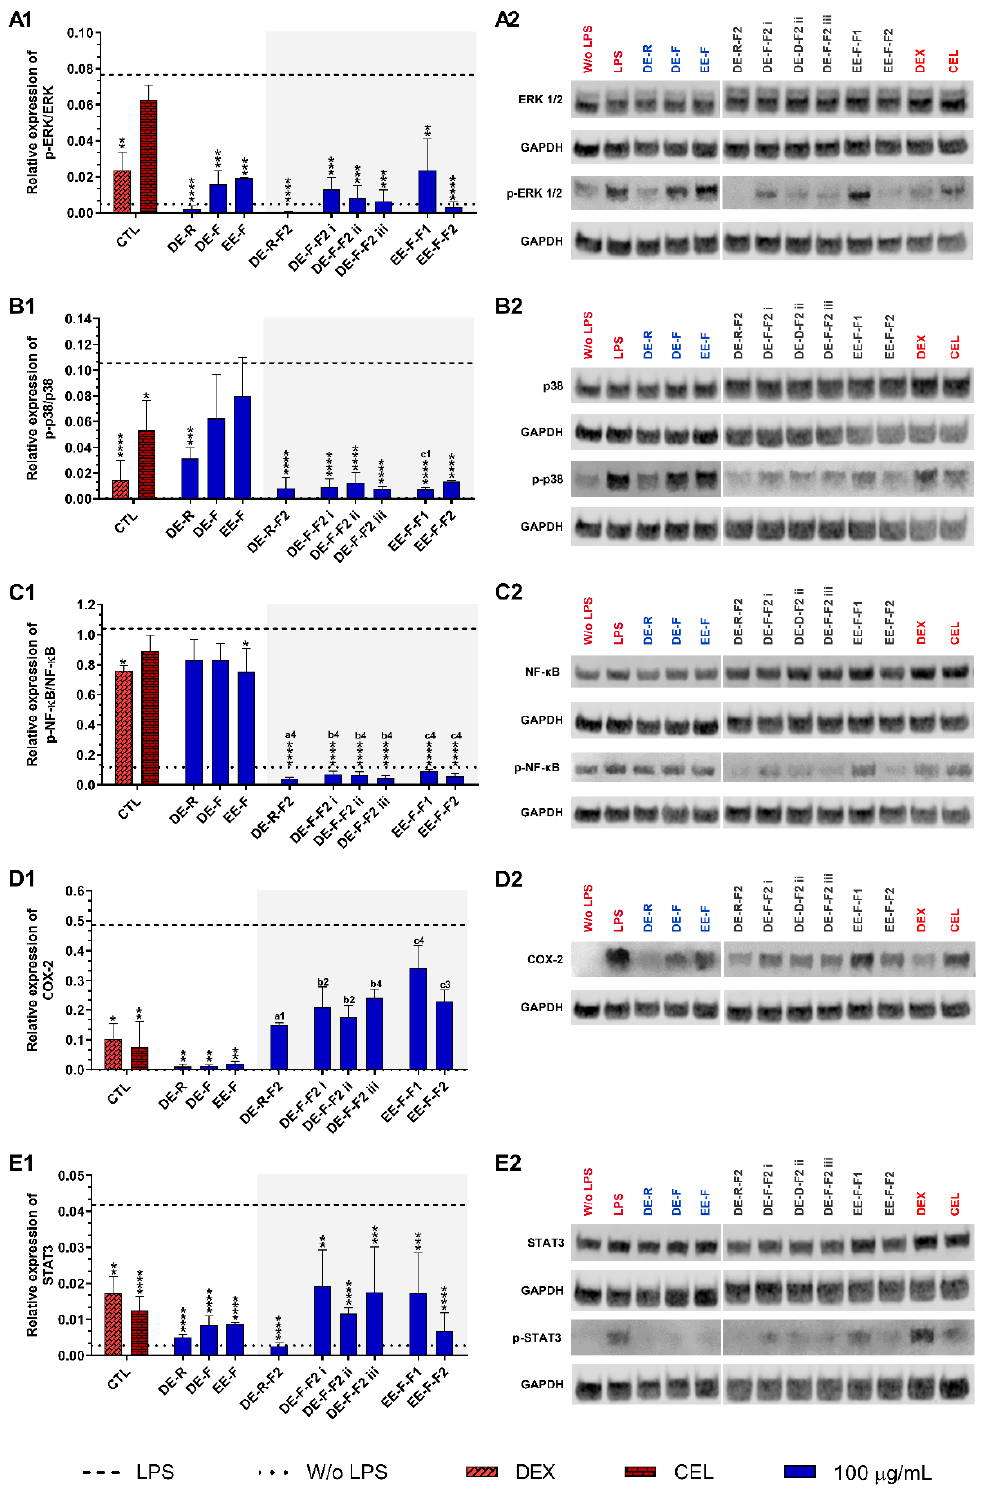
Figure 7. ERK 1/2 ( A1 , A2 ), p38 ( B1 , B2 ), NF ‐κ B p65 ( C1 , C2 ), COX ‐ 2 ( D1 , D2 ), and STAT3 ( E1 , E2 ) signaling pathways downregulation of LPS ‐ stimulated human monocyte ‐ derived macrophages (hMDMs) cultured in the presence of E. purpurea extracts, factions, and clinically used anti ‐ inflammatory drugs (dexamethasone (DEX) and celecoxib (CEL), 10 μ M) for 24 h. Statistically significant differences are * ( p < 0.0381), ** ( p < 0.0071), *** ( p < 0.0009), and **** ( p < 0.0001) in comparison to the positive control (LPS ‐ stimulated hMDM without treatment) for each tested E. purpurea extract and fraction, as well as DEX and CEL and 1 ( p < 0.0358), 2 ( p < 0.0023), 3 ( p < 0.0002), and 4 ( p < 0.0001) in comparison with a (DE ‐ R vs. DE ‐ R ‐ F2), b (DE ‐ F vs. DE ‐ R ‐ F2), and c (EE ‐ F vs. EE ‐ F ‐ F) at the same